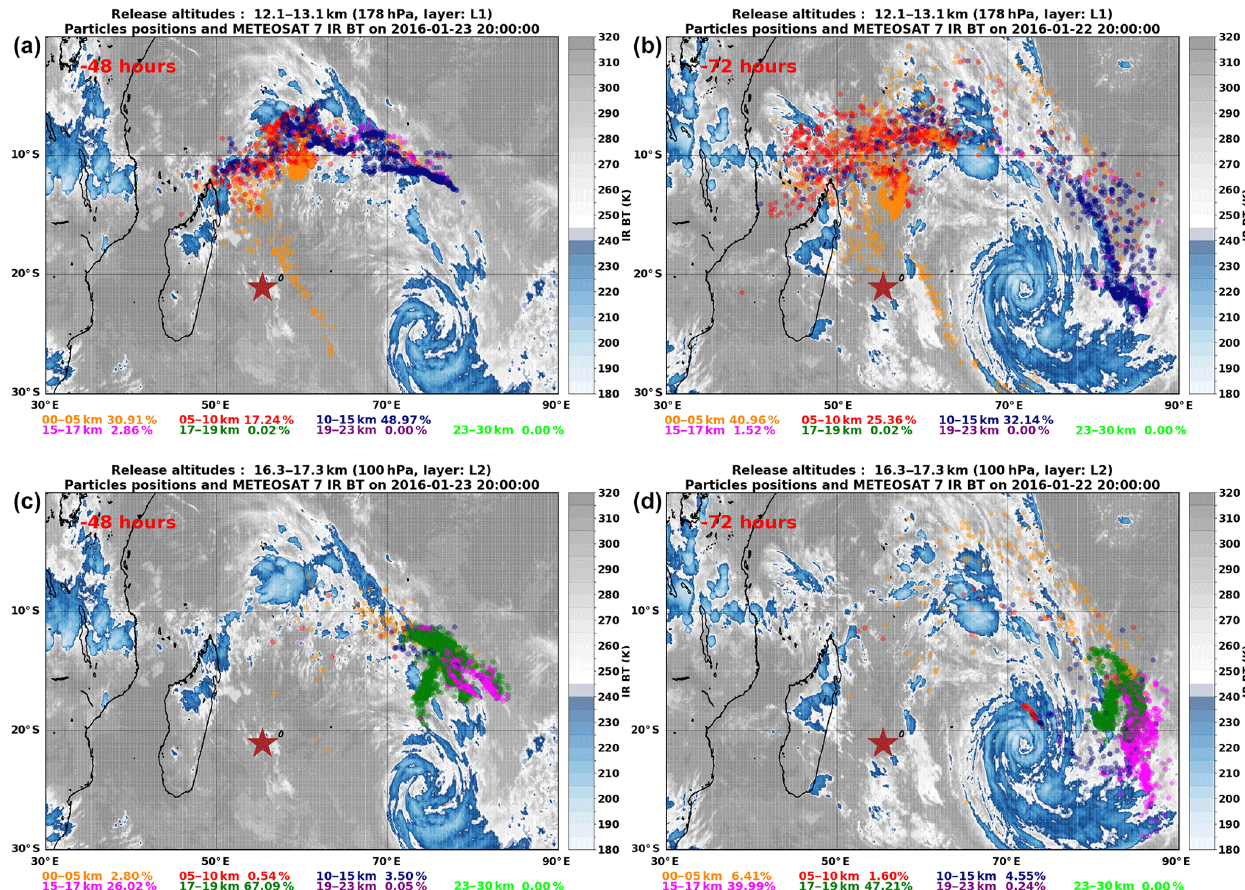
Figure 6. Backward trajectories calculated with the FLEXPART model for the CFH flight on 25 January 2016. In (a) and (b) , backward trajectories were initialized at 178hPa (layer L1) on 25 January 2016. The particle positions 2d before (on 23 January 2016 at 20:00UTC; a ) and 3d before (on 22 January 2016 at 20:00UTC; b ) are shown with respect to the Meteosat-7 cloud distribution at those times. The altitude range of the particles (e.g., 0–5km) and the percent of particles in that altitude range are indicated according to a color code shown in the bottom of each panel. (c, d) Same as (a) and (b) but for backward trajectories initialized at 100hPa (layer L2) on 25 January